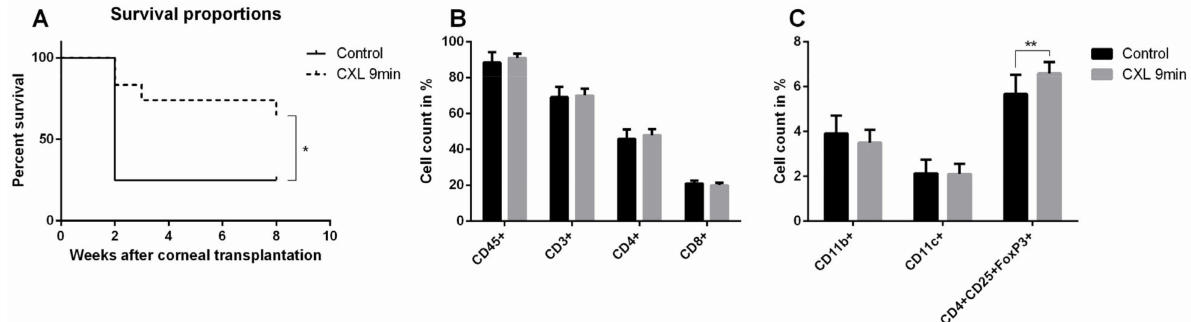
Figure 6. Promotion of graft survival and upregulation of T regulatory cells in vascularized high-risk eyes after pretreatment with UV-A-light based corneal collagen crosslinking (CXL; lymphangioregressive preconditioning). ( A ) The 9-min CXL treatment before corneal transplant significantly promoted corneal allograft survival in pretreated high-risk eyes 8 weeks after corneal transplantation (control: 25.0% graft survival, 9-min CXL: 66.7% graft survival; n = 12; * p < 0.05). ( B , C ) There were significantly more CD4+CD25+FoxP3+ cells in draining lymph nodes in the 9-min CXL-treated group than in the control group at 8 weeks post corneal transplant ( n = 12; ** p < 0.01). FACS analysis showed no statistical difference for CD3+, CD4+, CD8+, CD11b+, CD11c+, or CD45+ cells. From Hou et al. 2018